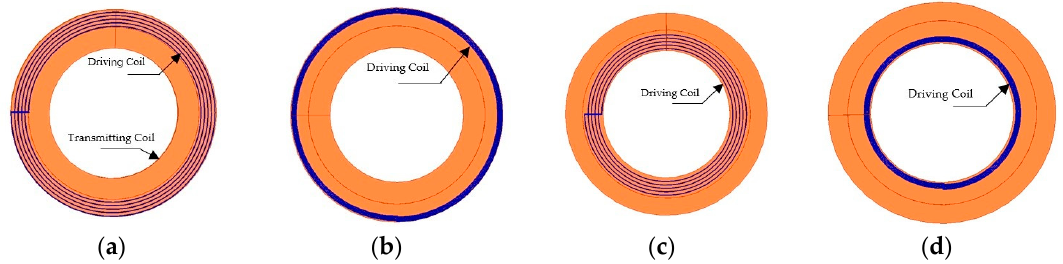
Figure 10. Typical arrangements of the driving coil: ( a ) loose outer, ( b ) tight outer, ( c ) loose inner, and ( d ) tight